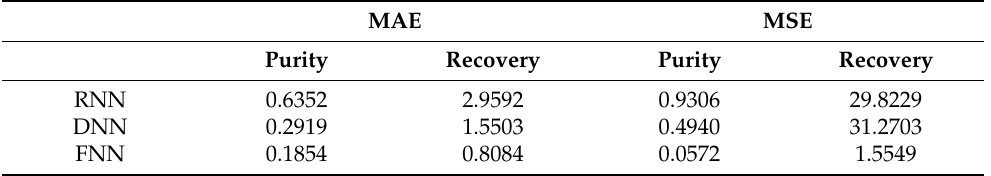
Table 4. Soft sensors performance indicators.